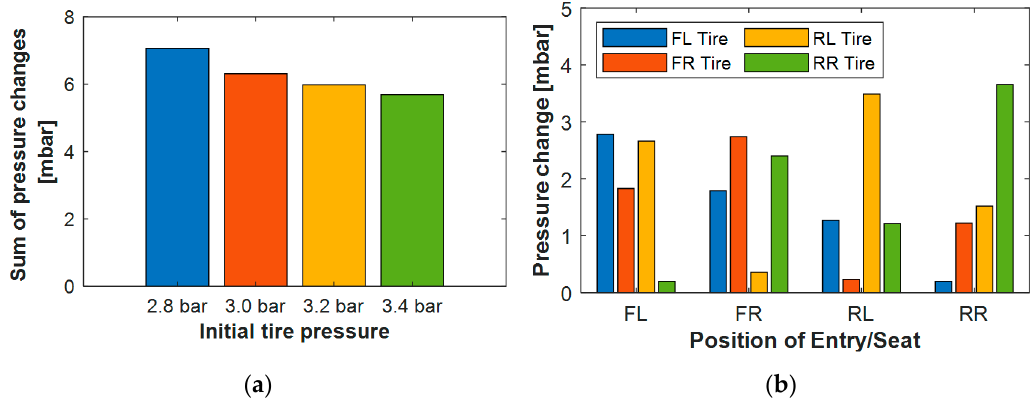
Figure 6. ( a ) Influence of initial pressure on height of mass induced pressure steps, sum of all four tires (car). ( b ) Influence of seat position on pressure changes (car).